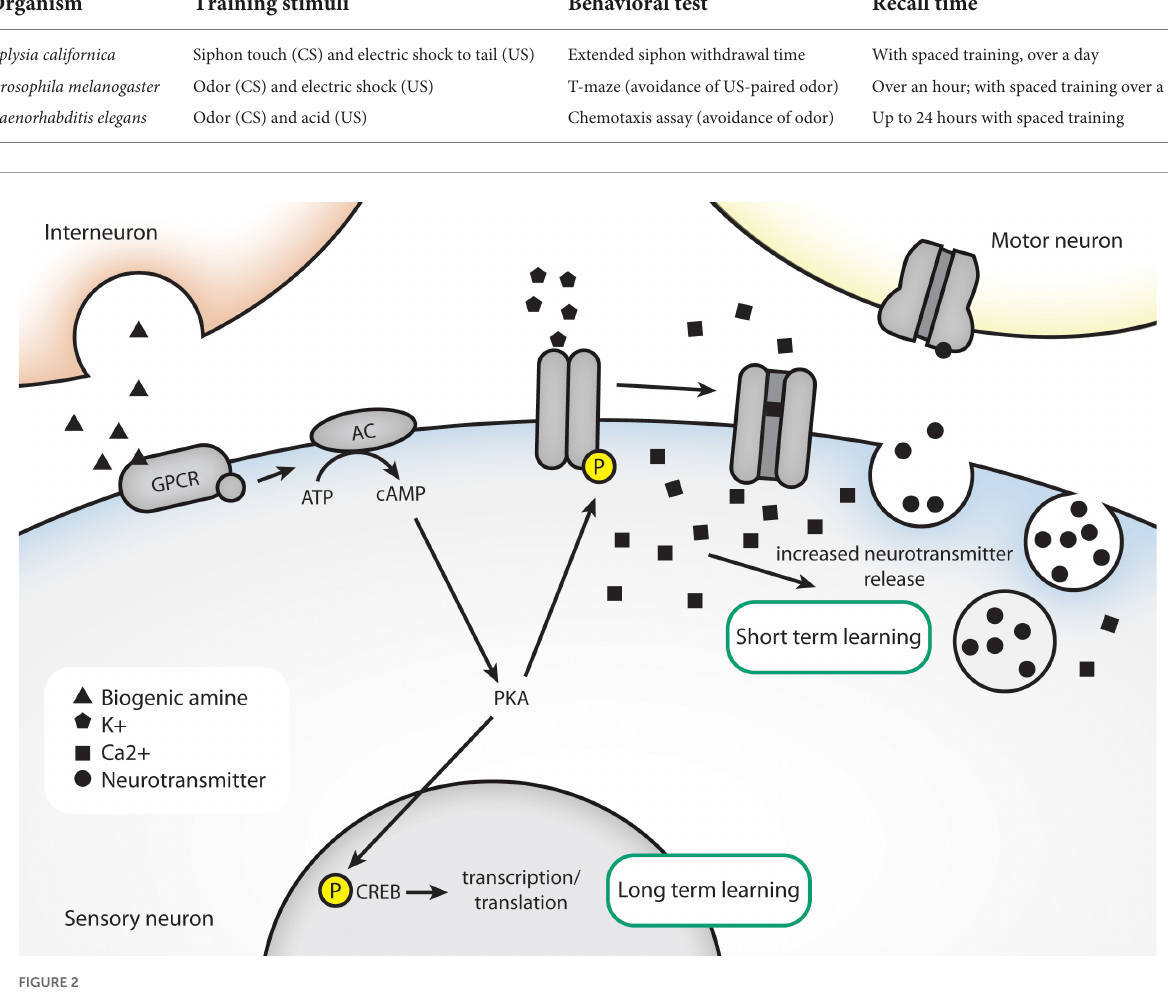
TABLE 1 A comparison of fear conditioning or fear conditioning-like schemes in each organism. Organism